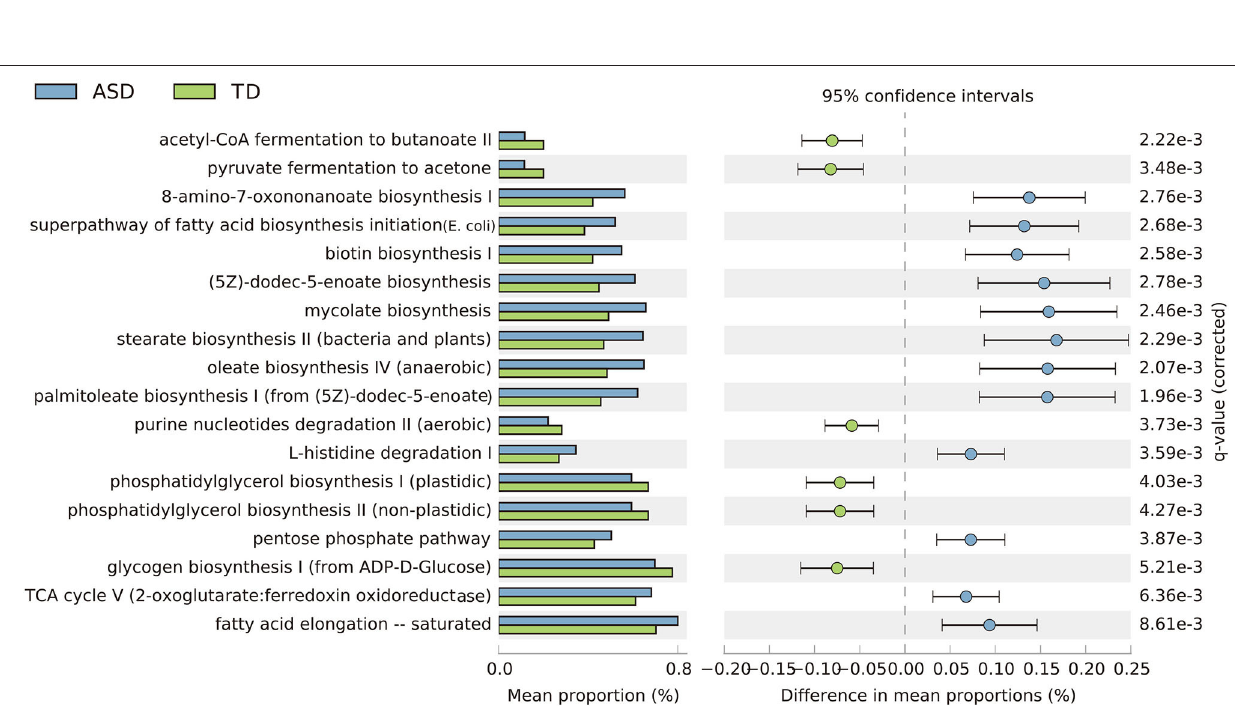
FIGURE 6 | Extended error bar plot showing 18 significantly different KEGG categories and abundance of the expression in the ASD and TD groups ( p < 0.001, effect size > 0.05. Benjamini–Hochberg FDR < 0.05).